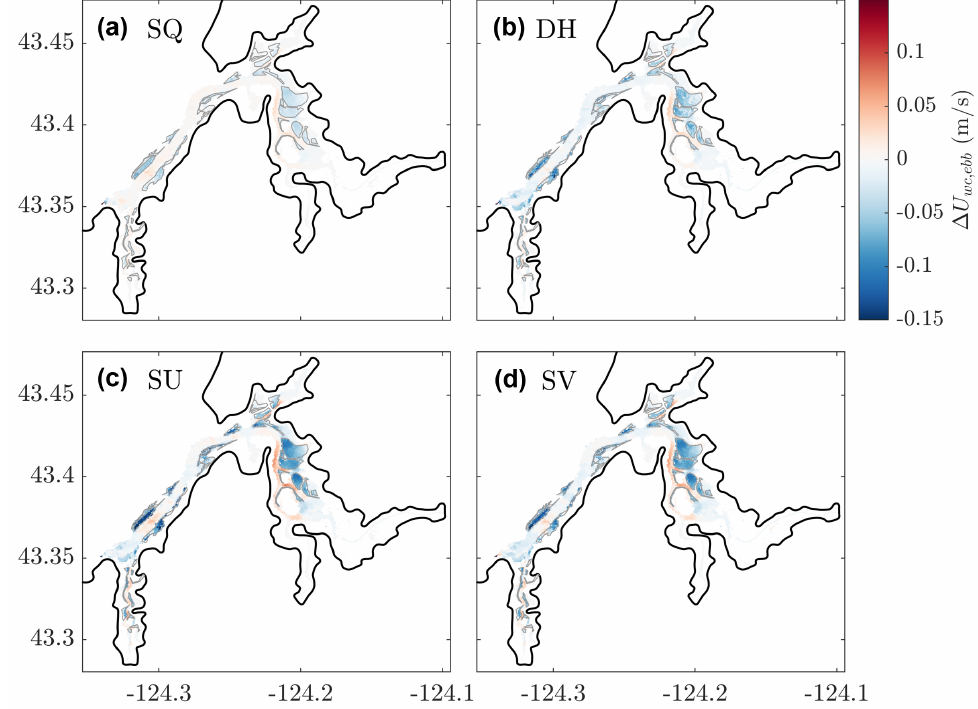
Figure 4. Change in combined wave-current velocity during peak ebb currents U wc , ebb by SAV parameterized as ( a ) SQ, ( b ) DH, ( c ) SU, and ( d ) SV, as compared to no-vegetation control. Horizontal and vertical axes correspond to longitude and latitude